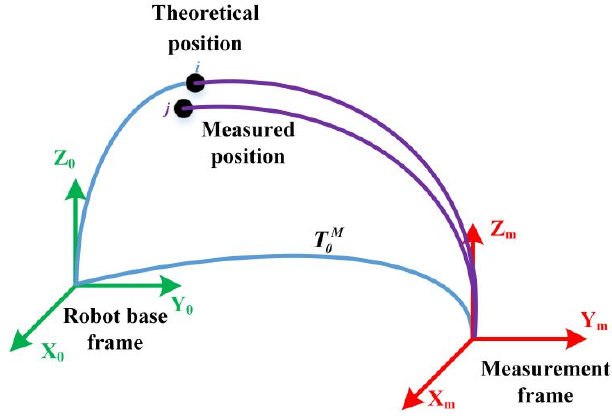
Figure 12. Experiment coordinate systems considering the measurement and robot base.